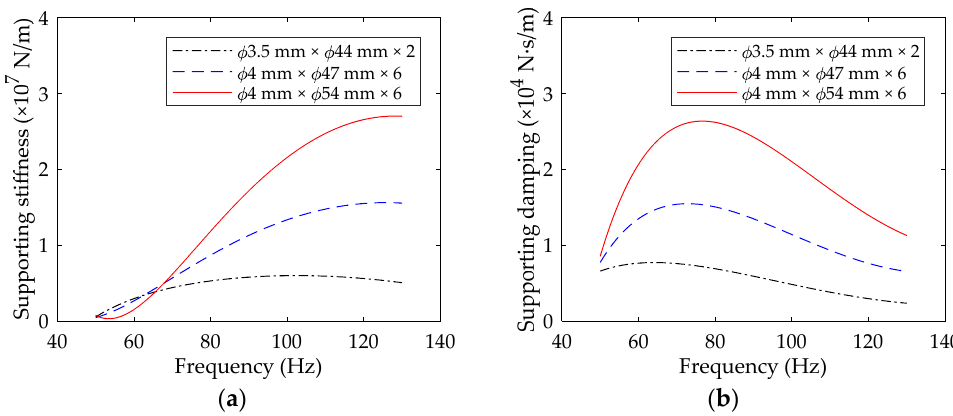
Figure 7. The curves of supporting stiffness and supporting damping of rubber O-ring. ( a ) Equivalent supporting stiffness curve; ( b ) equivalent supporting damping curve.